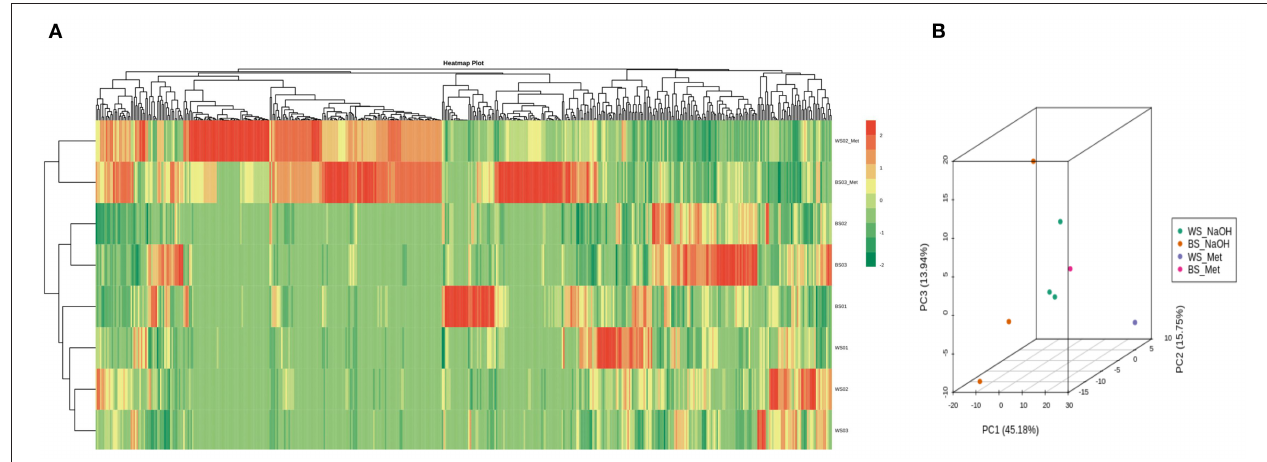
FIGURE 5 | Overview of metabolites profile of sesame seeds in methanol and NaOH extracts. (A) Heat map visualization. The profiles of all types of metabolites were normalized to complete the hierarchical clustering. Each sample is represented by one row, and each metabolite is visualized in one column. Red indicates high abundance; green indicates relatively low metabolite abundance. (B) Principal component analysis (PCA) result showing metabolite profile differences between and within groups. The sample labels are defined in Supplementary Table S1